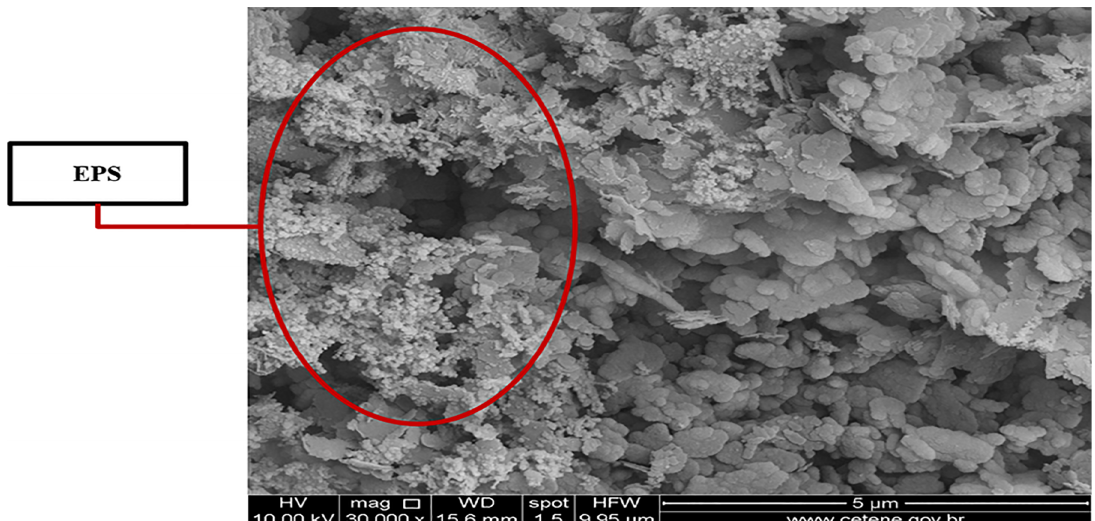
Figure 6. Microscopy of API 5LX60 carbon steel coupons with biofilm clayey